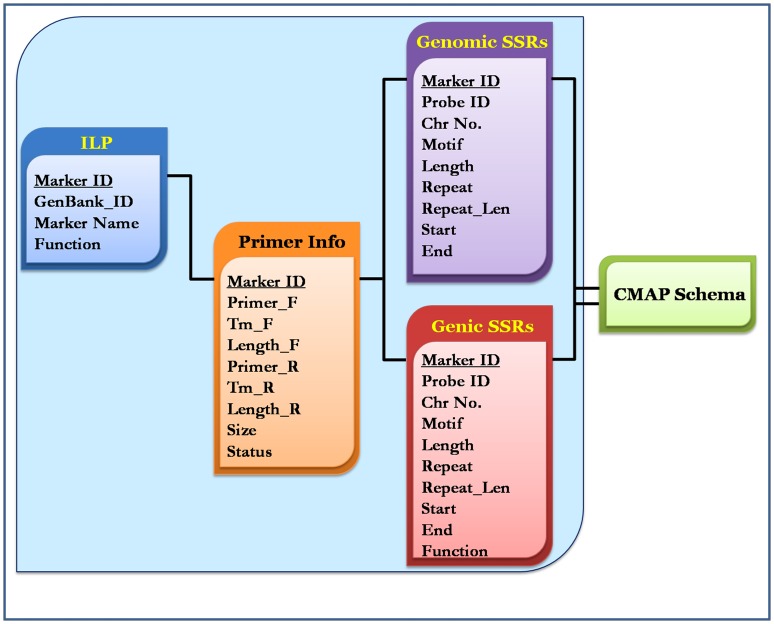
Database schema.